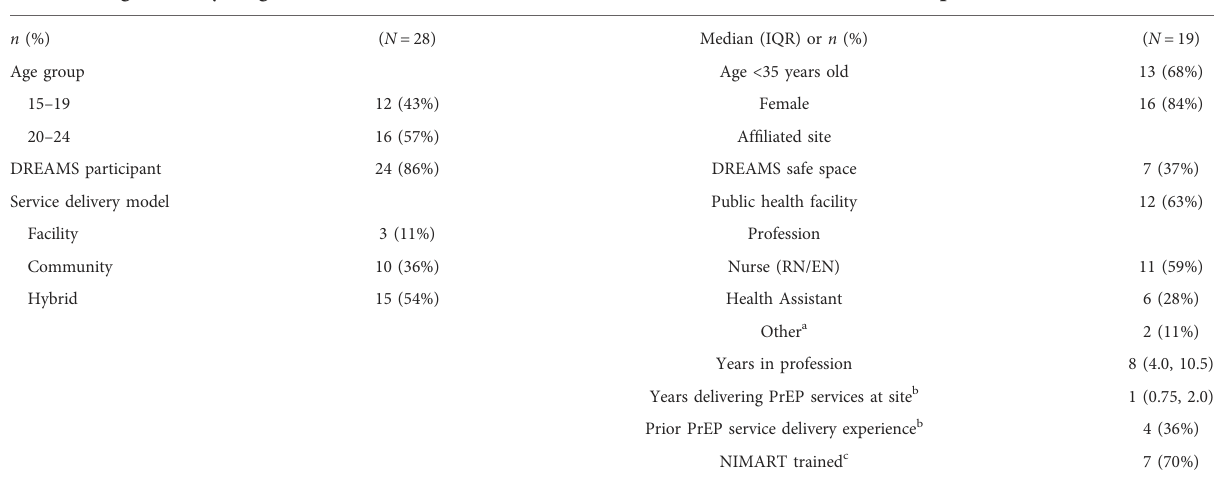
TABLE 2 Characteristics of in-depth interview